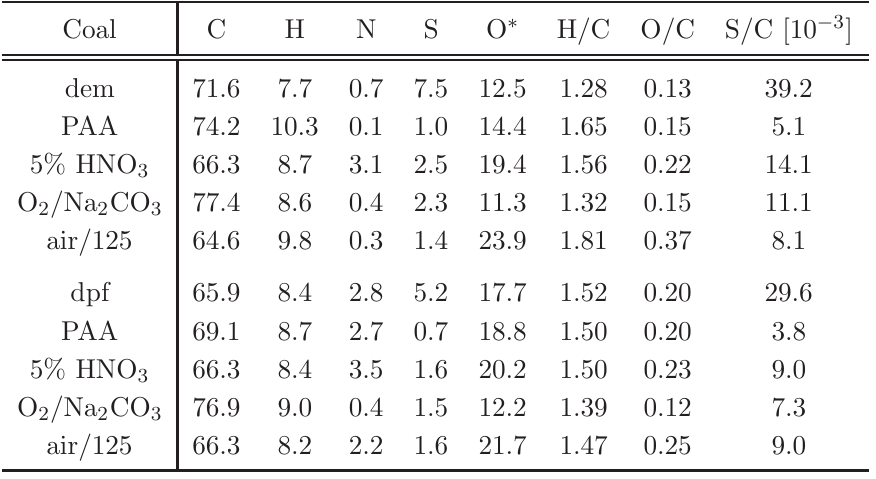
the CH Cl extract from the demineralised and pyrite free 2 2